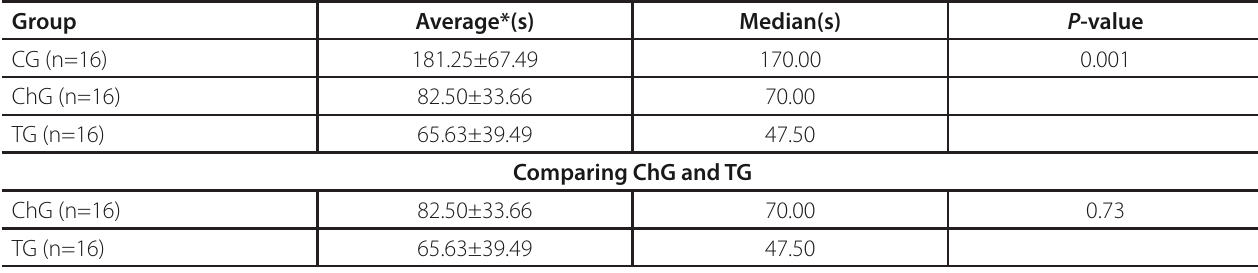
Table 1 . Time required to achieve haemostasis by group.